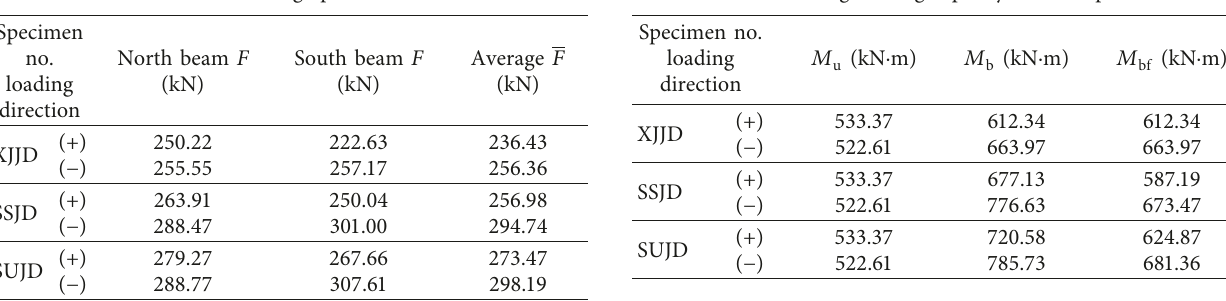
Table 7: Average peak loads. Table 8: Bending bearing capacity of each